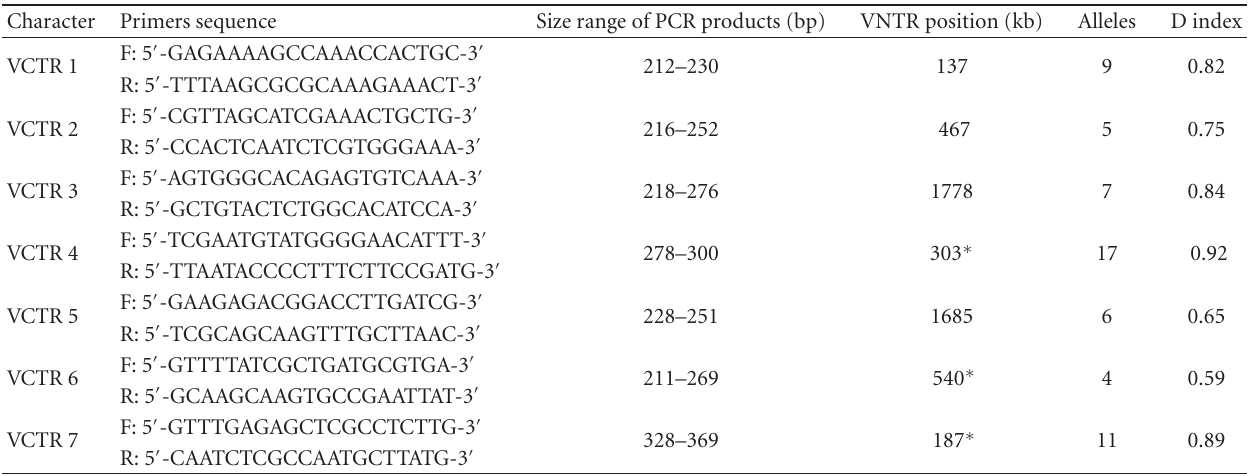
Table 1: Characteristics of V. cholerae VNTR loci.